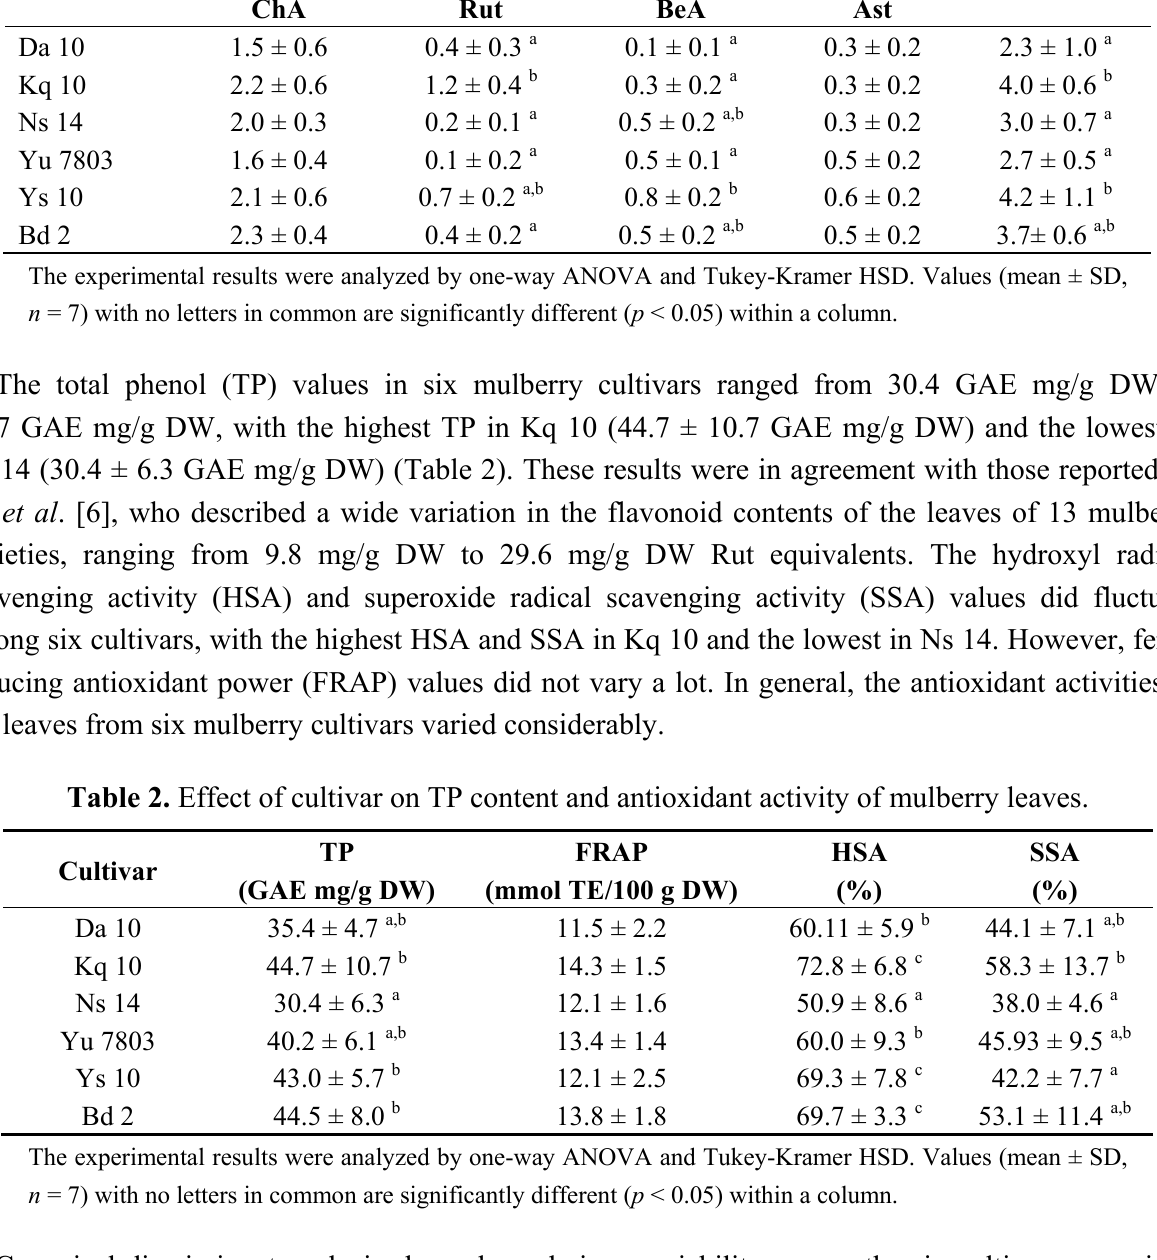
Table 1. Effect of cultivar on the content of phenolic compounds in mulberry leaves. Cultivar